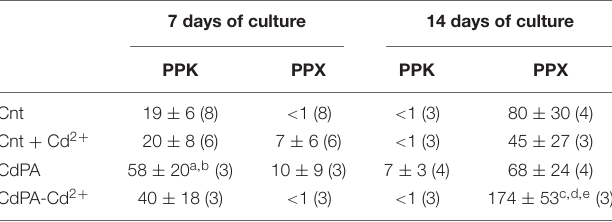
TABLE 2 | Polyphosphate kinase and PPX activities in Methanosarcina